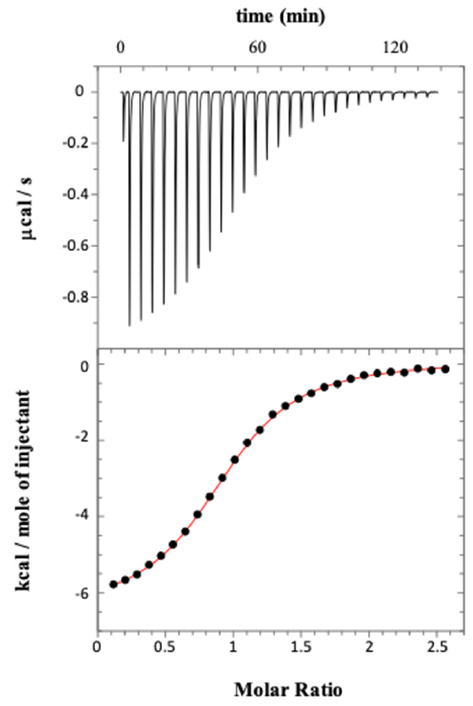
Figure 7. Microcalorimetric titration of butylsulfonate (G) with pillar[5]arene (H) in water at 25 °C. ( Top ): Raw data for the 28 sequential injections (10 µL per injection) of a solution of G (0.5 mM) into a solution of H (0.04 mM). ( Bottom ): “Net” heat effects fitted using the “one set of sites” binding model. Table 2. Thermodynamic parameters obtained for host:guest complexes between pillararene and different alkylsulfonates.